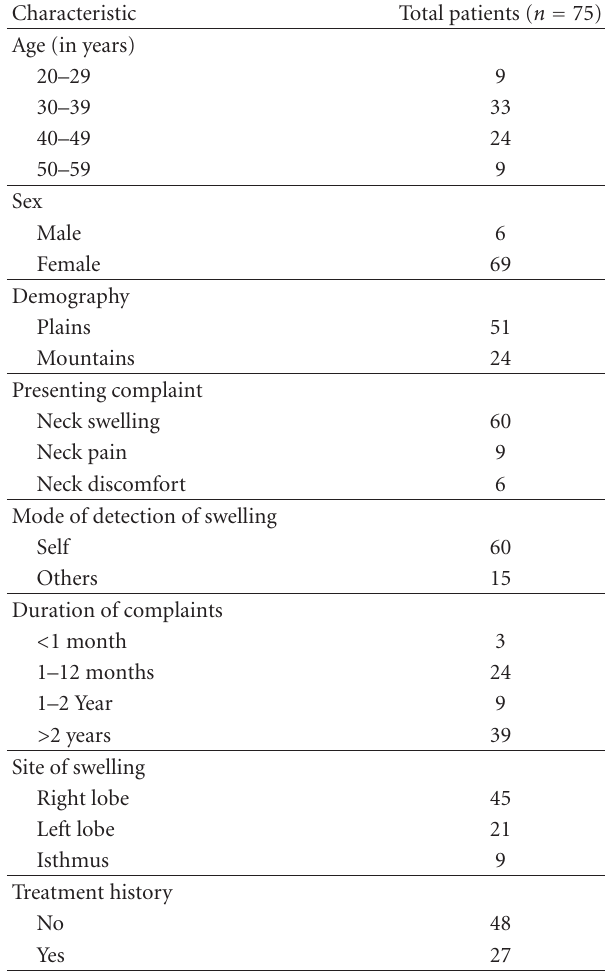
Table 1: Characteristics of the patients presented with clinically solitary thyroid